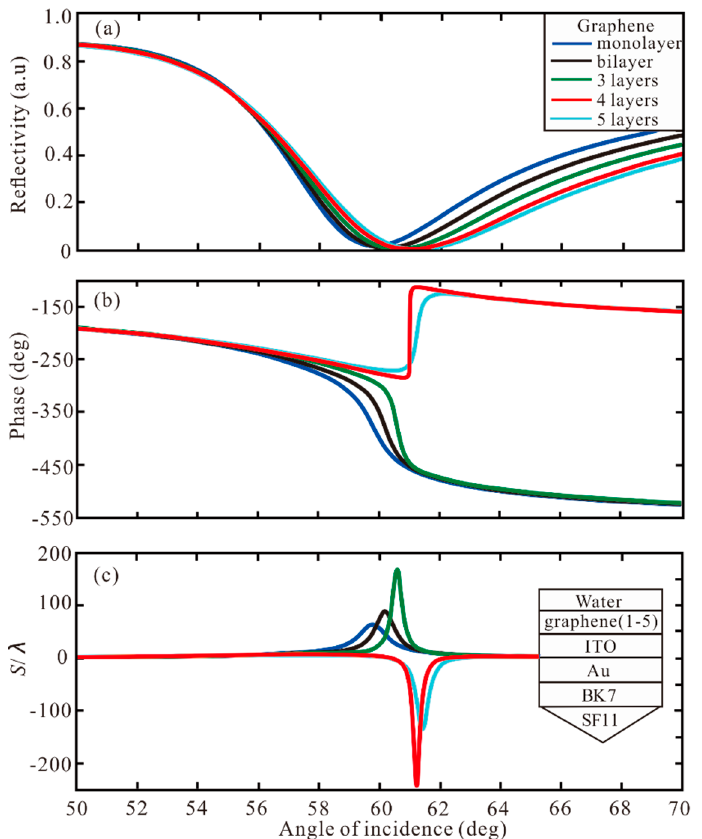
Figure 3. The change of ( a ) reflectivity, ( b ) phase, and ( c ) GH shift with respect to angle of incidence for di ff erent number of graphene layers.